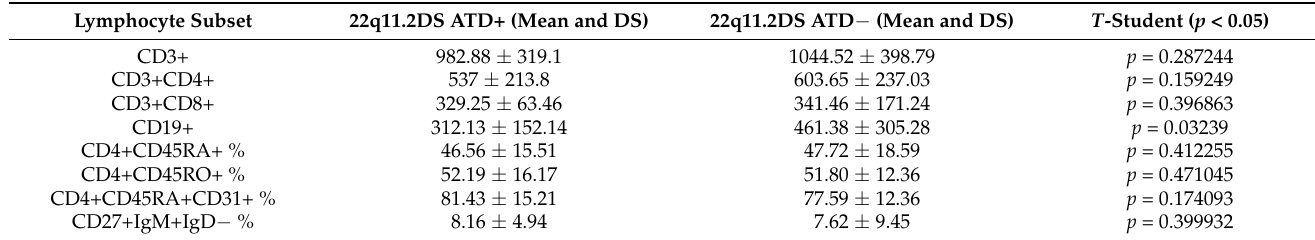
Table 4. Lymphocyte Subset Analysis in 22q11DS with and without ATD. Lymphocyte Subset 22q11.2DS ATD+ (Mean and